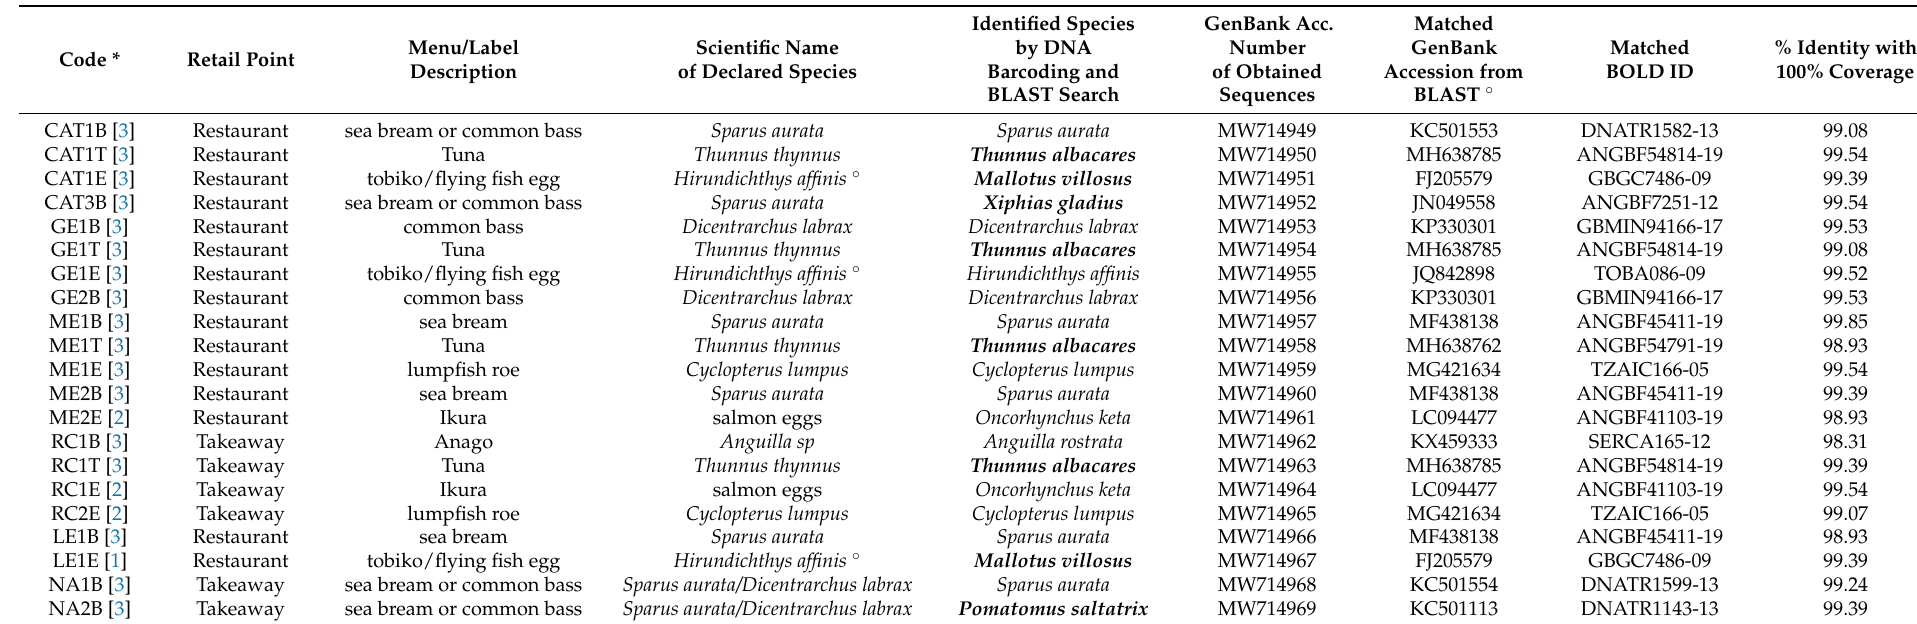
Table 3. Sushi sampling in Southern Italy. In square brackets, the number of processed samples for each sushi product. In bold, misdescription cases.